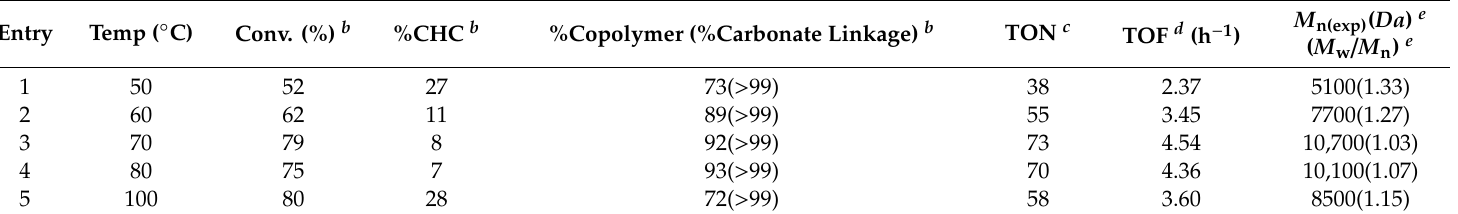
Table 3. E ff ect of reaction temperature on the synthesis of poly(cyclohexene carbonate) catalysed by complex 4 a .